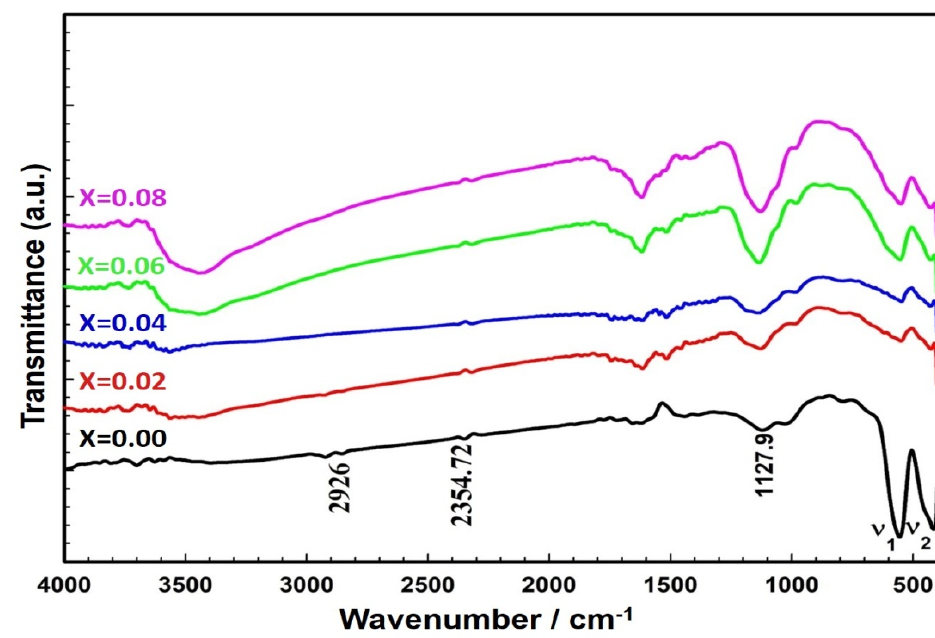
Figure 2. FTIR spectra of ZnCe x Fe 2 − x O 4 (X = 0.0, 0.02, 0.04, 0.06, 0.08) samples. Table 1. Absorption bands at the tetrahedral and octahedral sites of ZnCe x Fe 2 − x O 4 (X = 0.00, 0.02, 0.04, 0.06, and 0.08). υ 1 υ 2 Doped Ferrites x cm − 1 cm − 1